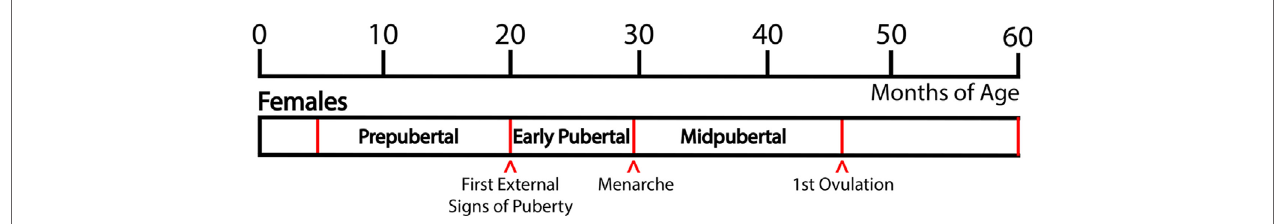
FiGURe 1 | Developmental stages of pubertal progression in female rhesus monkeys. Based on changes in physiological characteristics and in circulating hormone levels during the developmental course, prepubertal, early pubertal, and midpubertal stages are defined as shown in this figure. Actual age of the onset of puberty and subsequent progress vary among